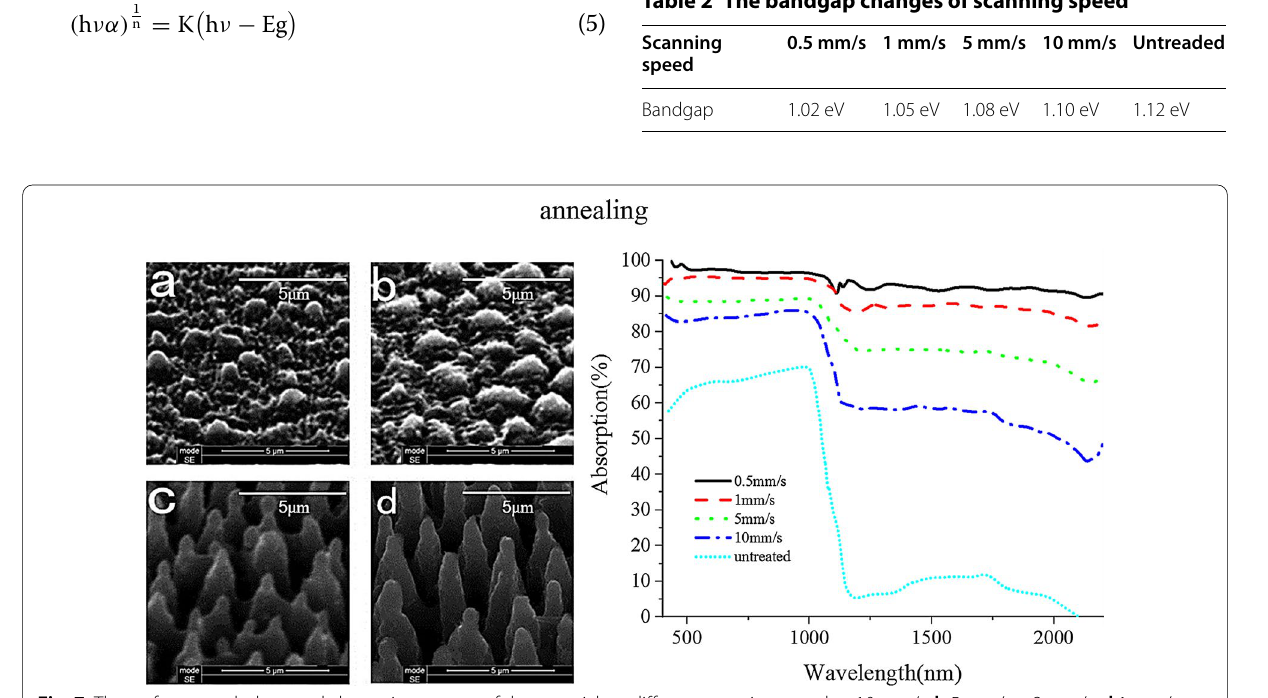
Fig. 7 The surface morphology and absorption spectra of the materials at different scanning speeds a 10 mm/s, b 5 mm/s, c 2 mm/s, d 1 mm/s